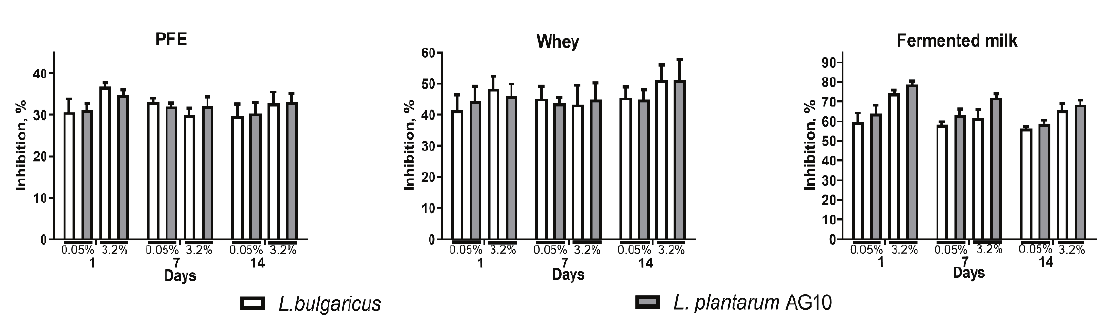
Figure 5. Radical-scavenging ability of protein-free extracts (PFE), whey, and whole fermented milk obtained with either L. bulgaricus (shown in white) or L. plantarum AG10 (shown in gray) measured in radical-scavenging ability (RSA) with the DPPH assay after 1, 7, and 14 days of storage. Asterisks show a significant difference at p < 0.05. The % of initial fat in the milk is shown under the x-axis. Finally, the peroxide number, FFA, and TBARS were lower throughout the storage time in the milk fermented by L. plantarum AG10, suggesting the presence of metabolites with antioxidant properties (Figure